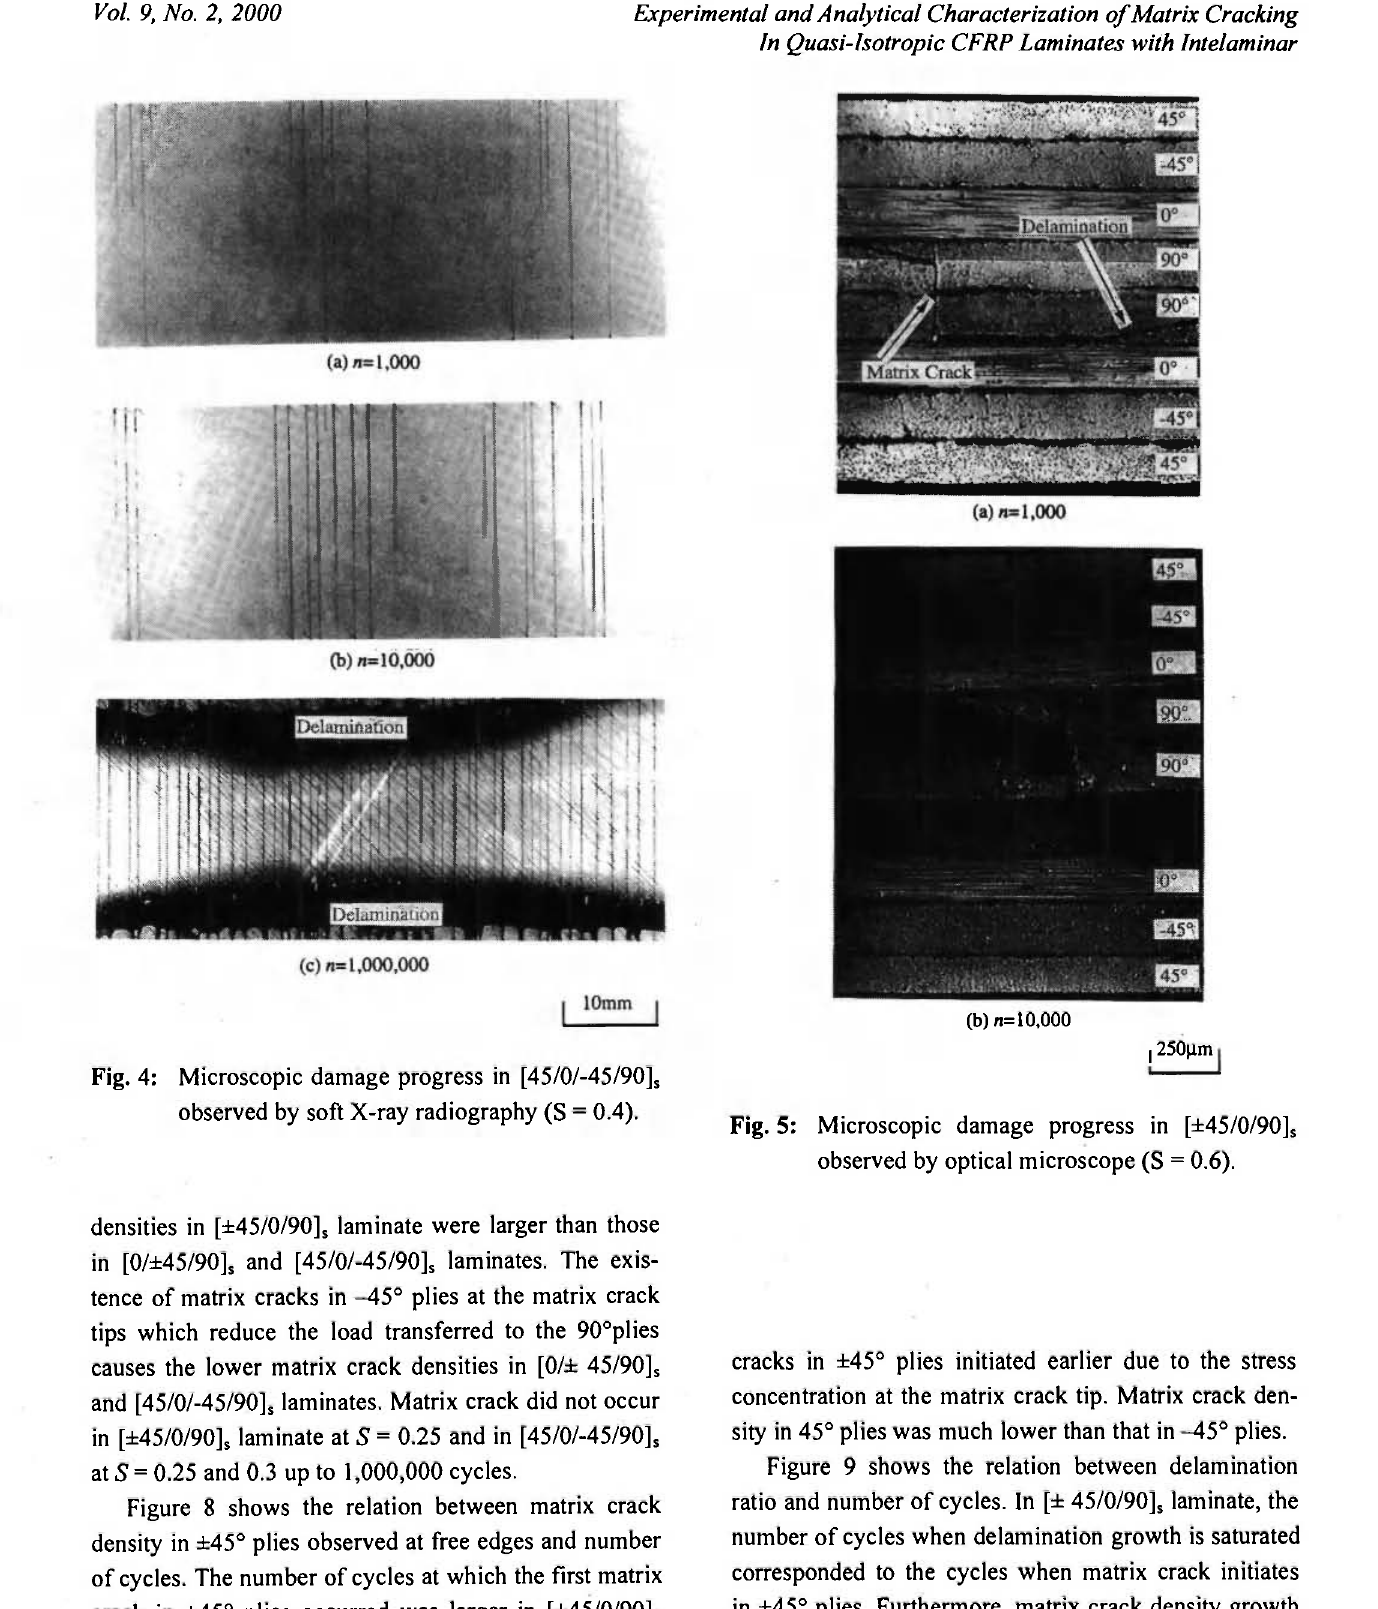
Fig. 5: Microscopic damage progress in [±45/0/90] s observed by optical microscope (S = 0.6).